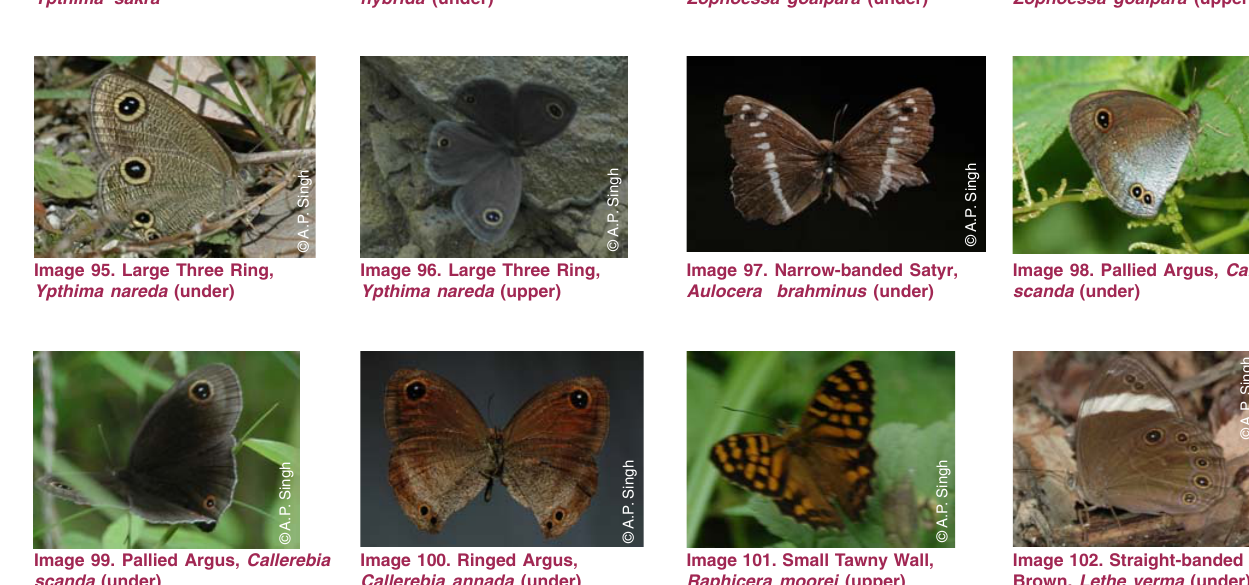
Image 99. Pallied Argus, Callerebia scanda (under)